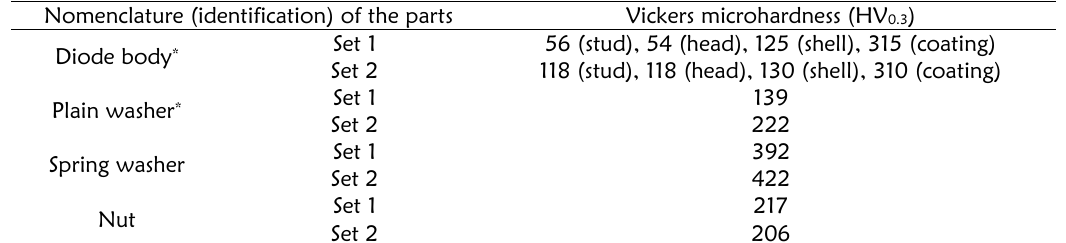
Table 3: Vickers microhardness readings at 300gf (w.r.t. Figures 3,